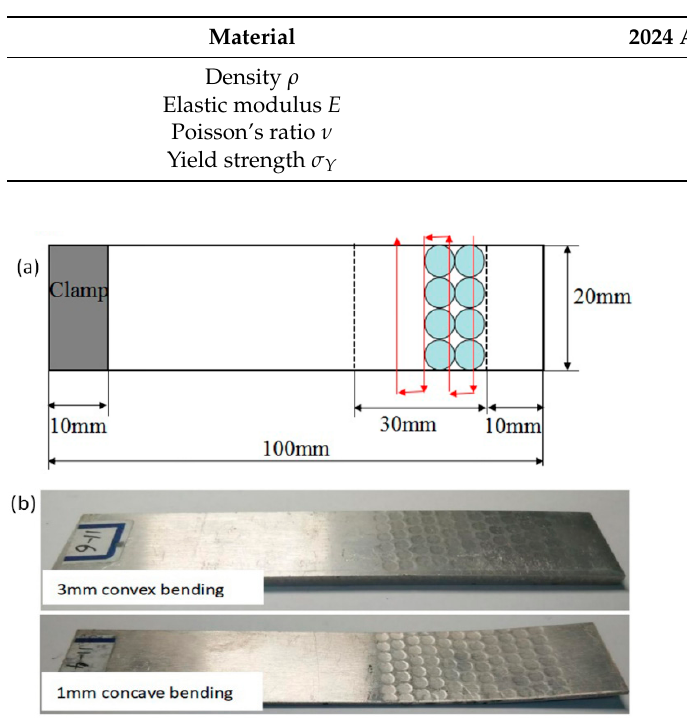
Figure 5. ( a ) Processing strategies of laser peen forming and ( b ) the typical